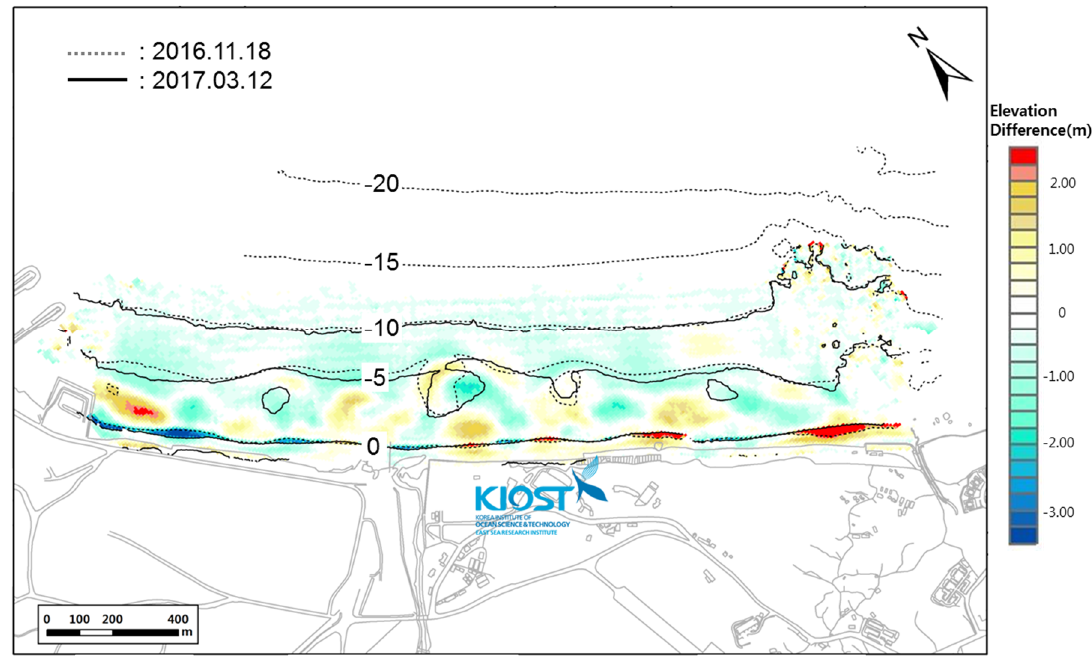
Figure 9. Seabed elevation changes in Hujeong Beach between 18 November 2016 (before T1) and 12 March 2017 (after T1). The figure is taken from [17].